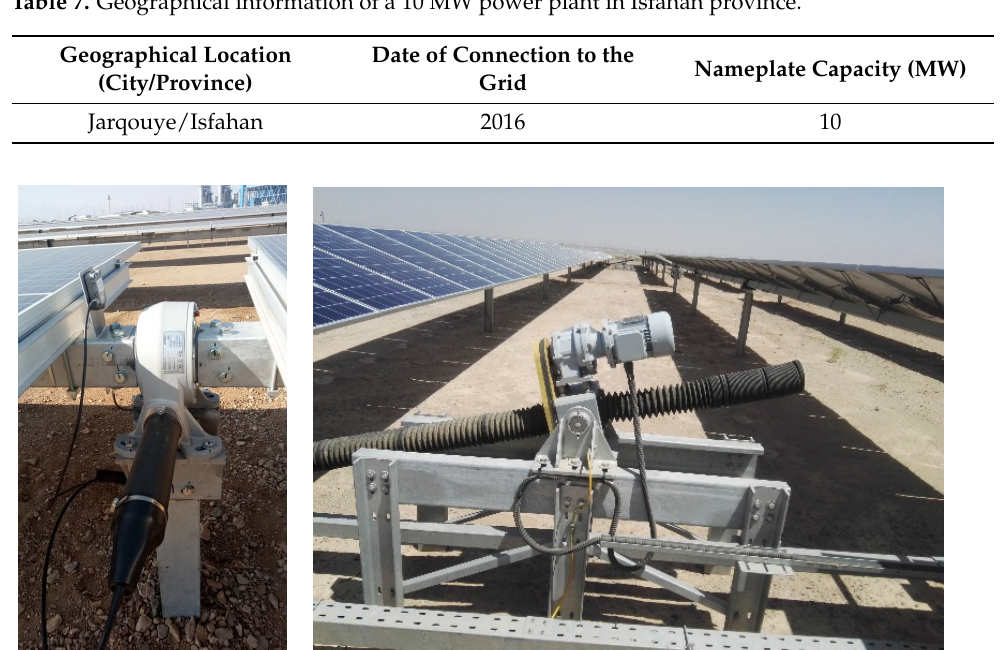
Table 7. Geographical information of a 10 MW power plant in Isfahan province.